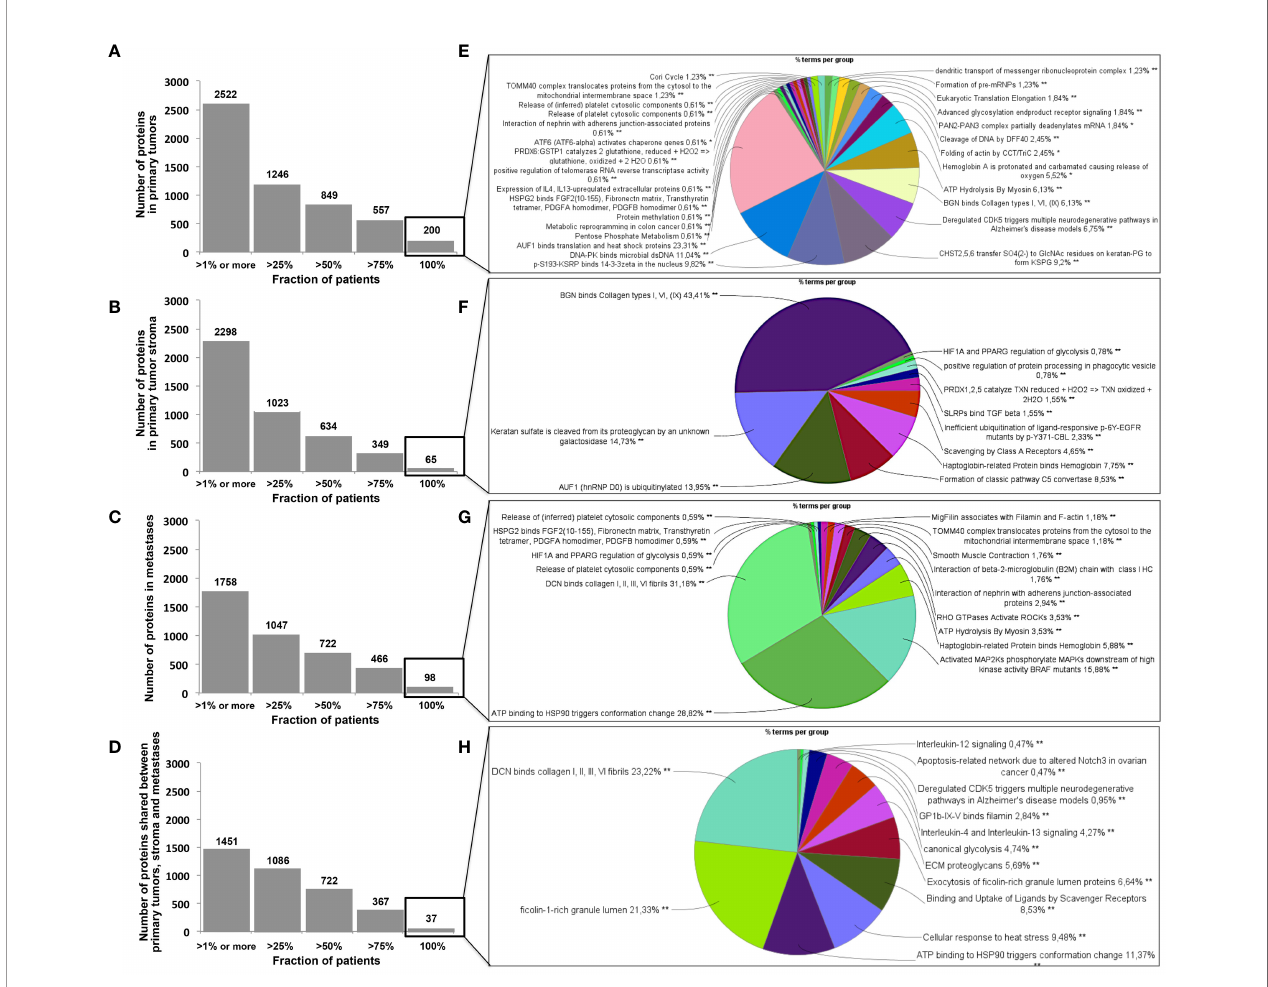
FIGURE 5 | Distribution of proteins among patients in (A) primary tumors, (B) in stroma, (C) in metastases, and (D) shared in all samples. Biological processes enriched (in %) from proteins shared by all patients in (A – D) are represented as pie charts in (E – H) , respectively. Analyses were performed with Cytoscape and ClueGo. *p < 0.05, **p < 0.01, ***p <